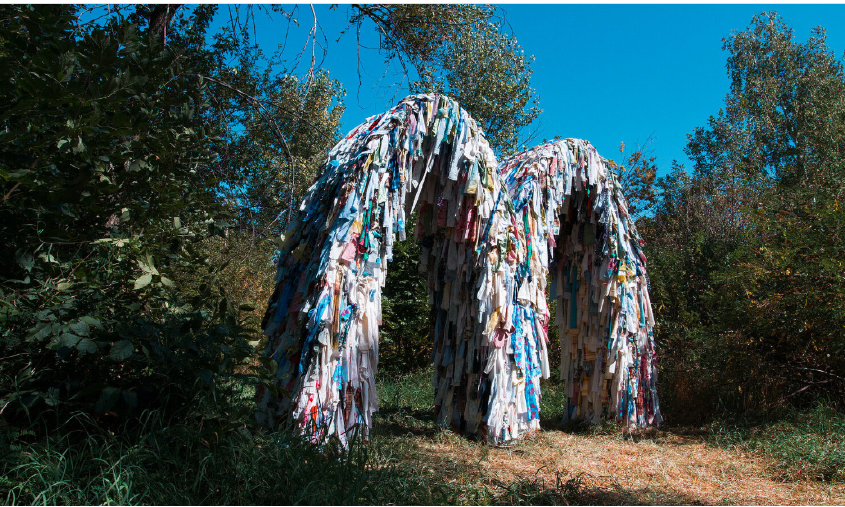
Figure 6. Anvar Musrepov, Place of Strength (2016). Image courtesy of the